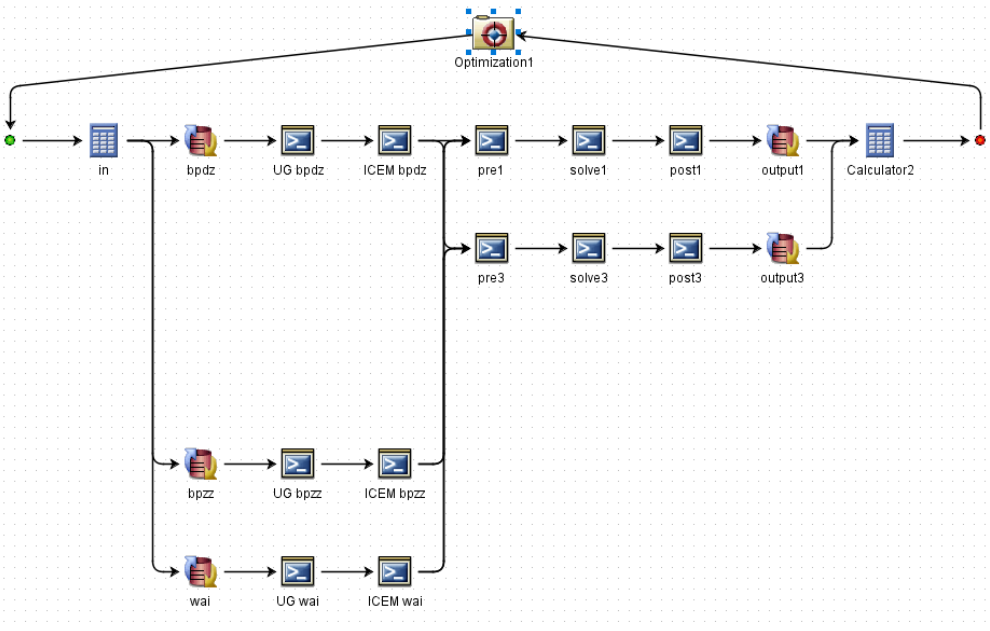
Figure 6. Establishment of the Isight optimization platform.